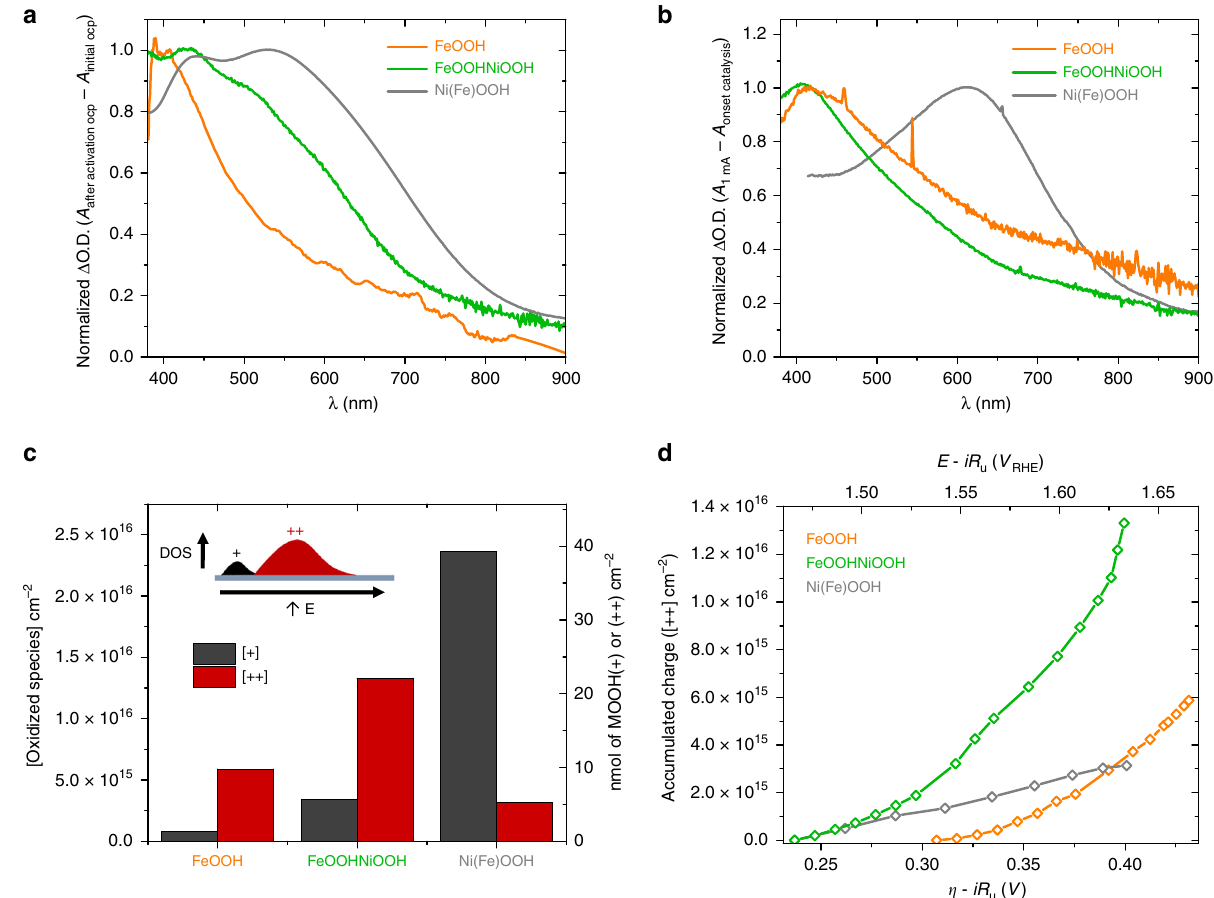
Fig. 2 Accumulated ( + ) and ( ++ ) species for each electrocatalyst. a Normalised Δ O.D. spectra (to 1 at peak Δ O.D.) for the fi rst (0/ + ) , precatalytic, oxidation of FeOOH (orange), FeOOHNiOOH (green) and Ni(Fe)OOH (grey), obtained from the difference between the spectra at open circuit potential (OCP) after and before activation. b Normalised Δ O.D. spectra for the ( + / ++ ) oxidation wave correlated with water oxidation for FeOOH (orange), FeOOHNiOOH (green) and Ni(Fe)OOH (grey), obtained by subtracting spectra at OCP after activation from the spectra at 1 mA cm − 2 of current density. c Concentrations of oxidised MOOH( + ) states generated in the activation process (black) and of MOOH( ++ ) states generated at a current density of 1 mA cm − 2 (red) for each electrocatalyst. Inset: schematic representation of the corresponding densities of states (DOS) for these electrocatalysts. d Accumulated concentrations of MOOH( ++ ) states vs. the applied overpotential (empty diamonds, solid lines). For both graphs FeOOH (orange), FeOOHNiOOH (green) and Ni(Fe)OOH